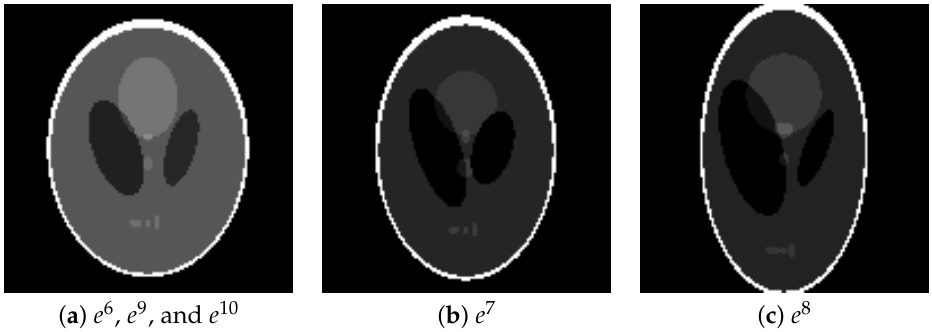
Figure 12. Phantom images of ( a ) e 6 , e 9 , and e 10 , ( b ) e 7 , and ( c ) e 8 for testing.